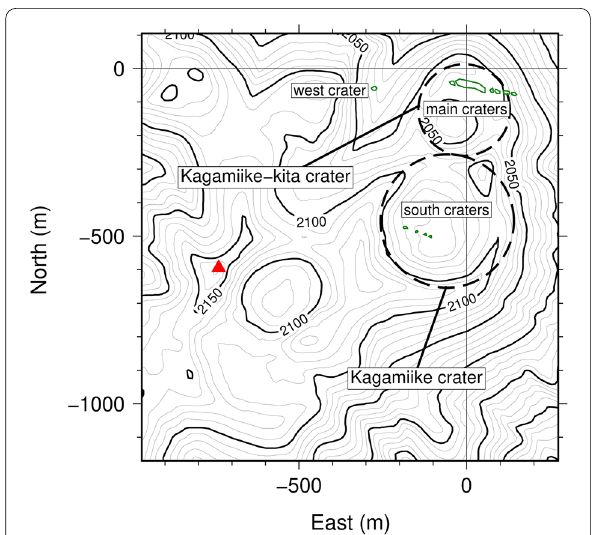
Fig. 2 Topographic map of Mount Motoshirane. The red triangle represents the summit of Mount Motoshirane. The two dashed lines represent the regions of the Kagamiike-kita and Kagamiike craters. The green lines indicate the outlines of the eruptive vents estimated by the Geospatial Information Authority of Japan (GSI